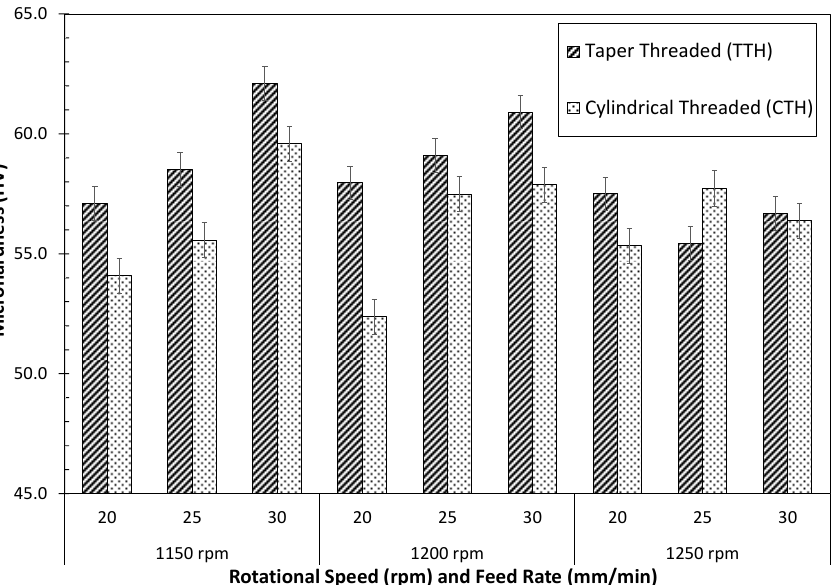
Figure 6. Average microhardness versus rotational speed and feed rate for TTH and CTH tool. The sample produced at 1150 rpm and 30 mm/min yielded the maximum average microhardness of 62.1 HV1 and 59.6 HV1, for both TTH and CTH FSP tools, respectively.